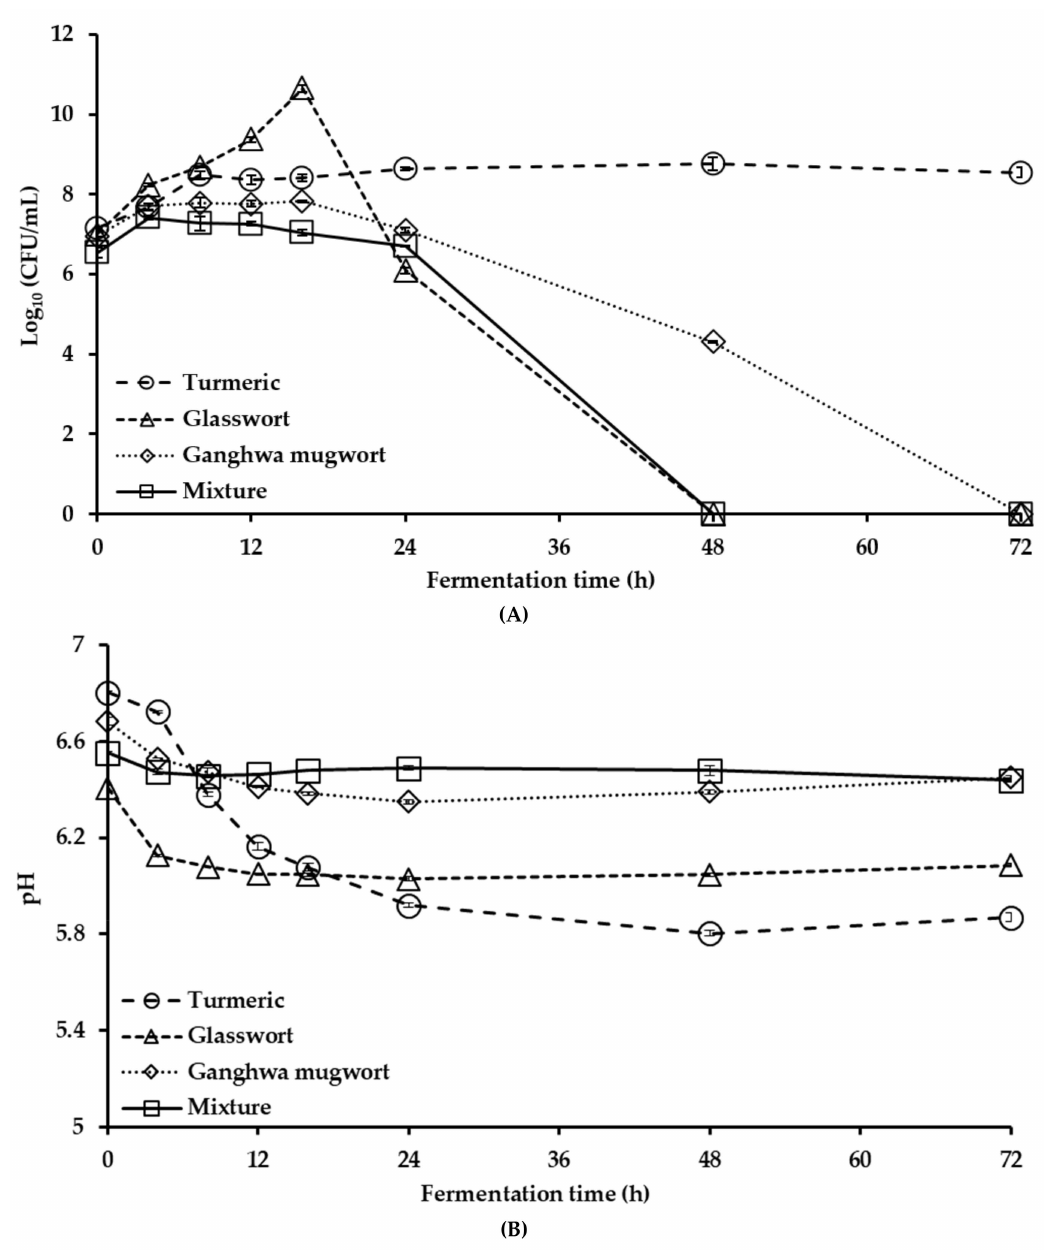
Figure 1. Changes in ( A ) bacterial cell counts and ( B ) pH during the fermentation of 5% ( w / v ) turmeric, 2.5% ( w / v ) glasswort, 2.5% ( w / v ) Ganghwa mugwort, and their 5% ( w / v ) mixture (1.66% ( w / v ) turmeric, 1.66% ( w / v ) glasswort and 1.66% ( w / v ) Ganghwa